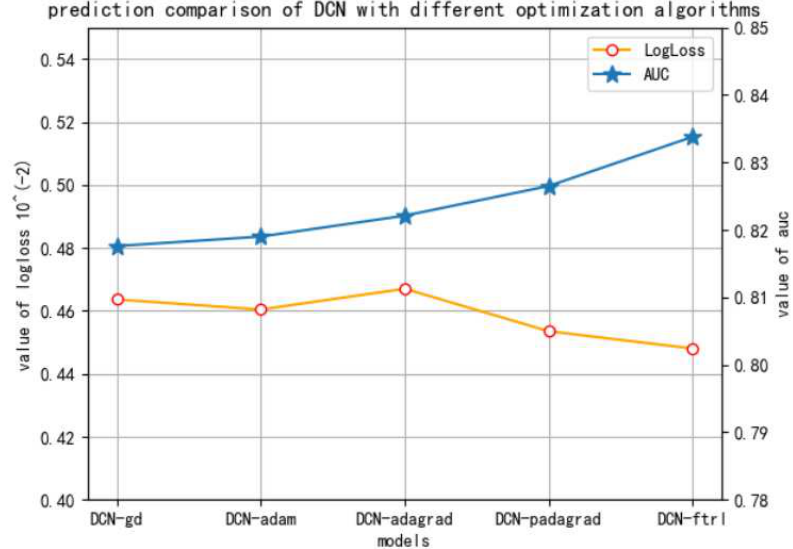
Figure 7. The comparison of DCN with different optimization algorithms.